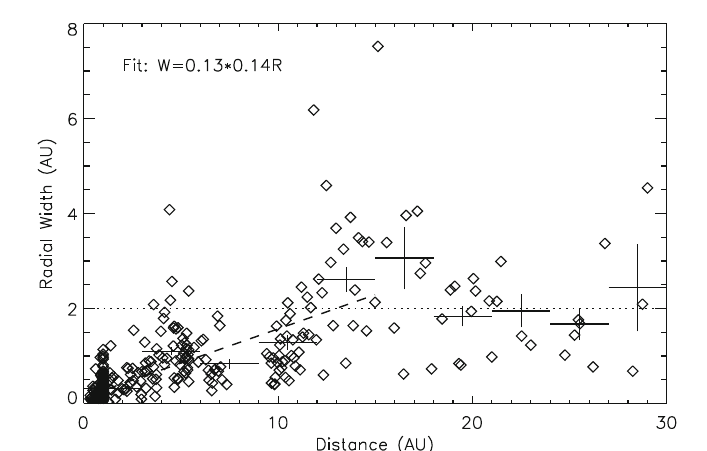
Fig. 26 The width of ICMEs as a function of the heliospheric distance R from the Sun. Diamonds show the radial widths of ICMEs that were combined by Richardson et al. (2006) using previously published ICME lists. The widths averaged over 3AU are shown by horizontal bars and the vertical bars give the error of the mean. The dashed line gives the best linear fit to observations inside 15AU where ICMEs generally still expand. Image reproduced by permission from Richardson et al. (2006), copyright by